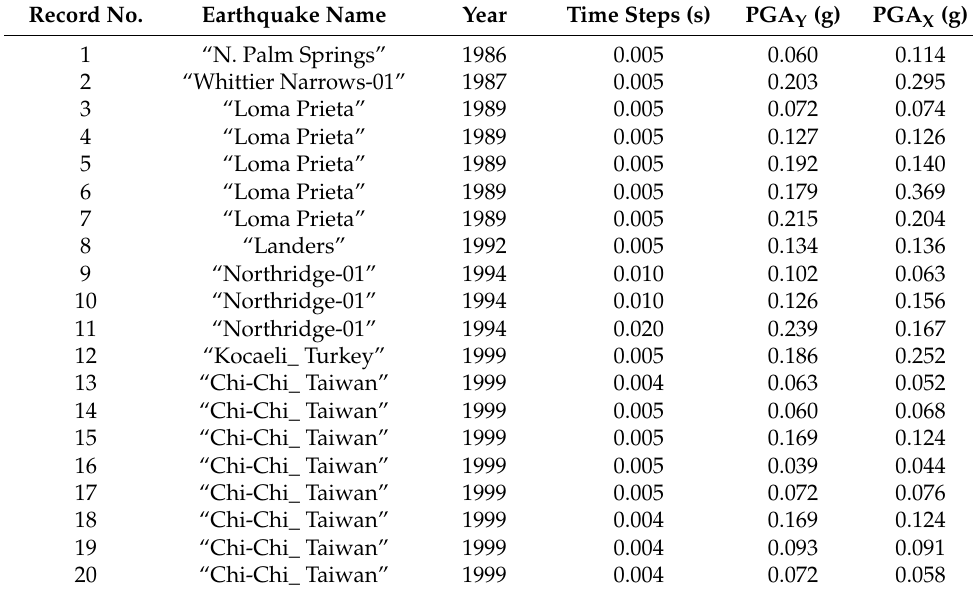
Table 4. Earthquake event and parameters of recorded ground motion for far-field records set. Record